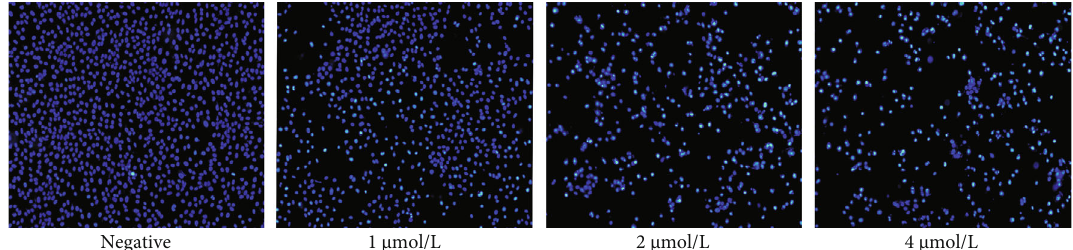
Figure 5: Anlotinib induced apoptosis in HSC-3 cells. After HSC-3 cells were treated with di ff erent concentrations (0, 1, 2, and 4 μ M/L) of anlotinib for 72h, apoptosis was detected by Hoechst 33258 staining, which showed that apoptotic cells gradually increased from low to high drug